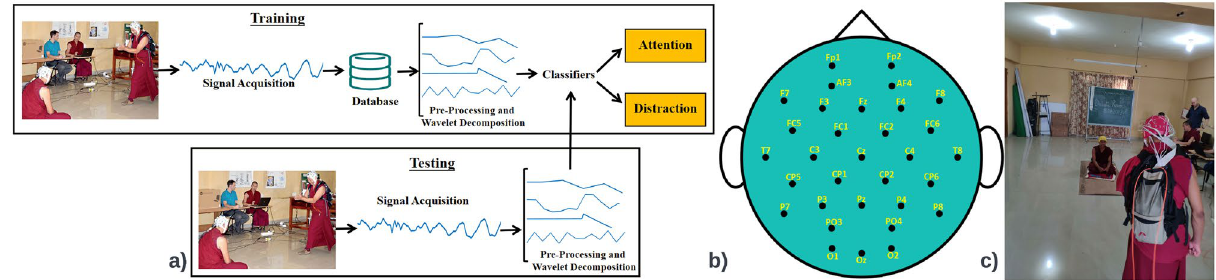
Figure 1. (a) Framework of the recognition system used for classifying attention and distraction states. (b) Electrode positions as per the 10–20 International system belonging to Biosemi 32 channel EEG device used for data collection. (c) Experiment setup. EEG being recorded from both the participants simultaneously during a monastic debate with raters of attentional state in the